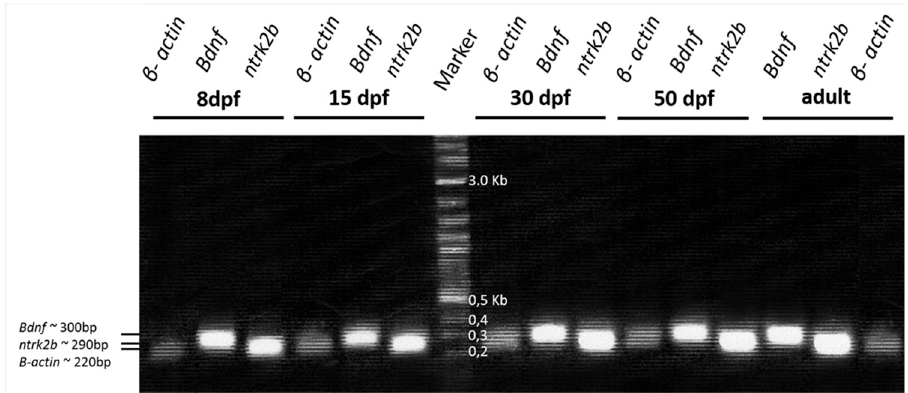
Figure 5. RT-PCR, Bdnf and ntrk2b mRNA expression in the inner ear from larval to adult stage. B-actin controls for each condition are also shown. Lines 1, 2 and 3: detection of β -actin, Bdnf and ntrk2b at 8 dpf. Lines 4, 5 and 6: detection of β -actin , Bdnf and ntrk2b at 15 dpf. Line 7 Marker. Lines 8, 9 and 10: detection of β -actin , Bdnf and ntrk2b at 30 dpf. Lines 11, 12 and 13: detection of β -actin, Bdnf and ntrk2b at 50 dpf. Lines 14, 15 and 16: Bdnf, ntrk2b and β -actin in the adult stage. The size of the amplified fragment is indicated.